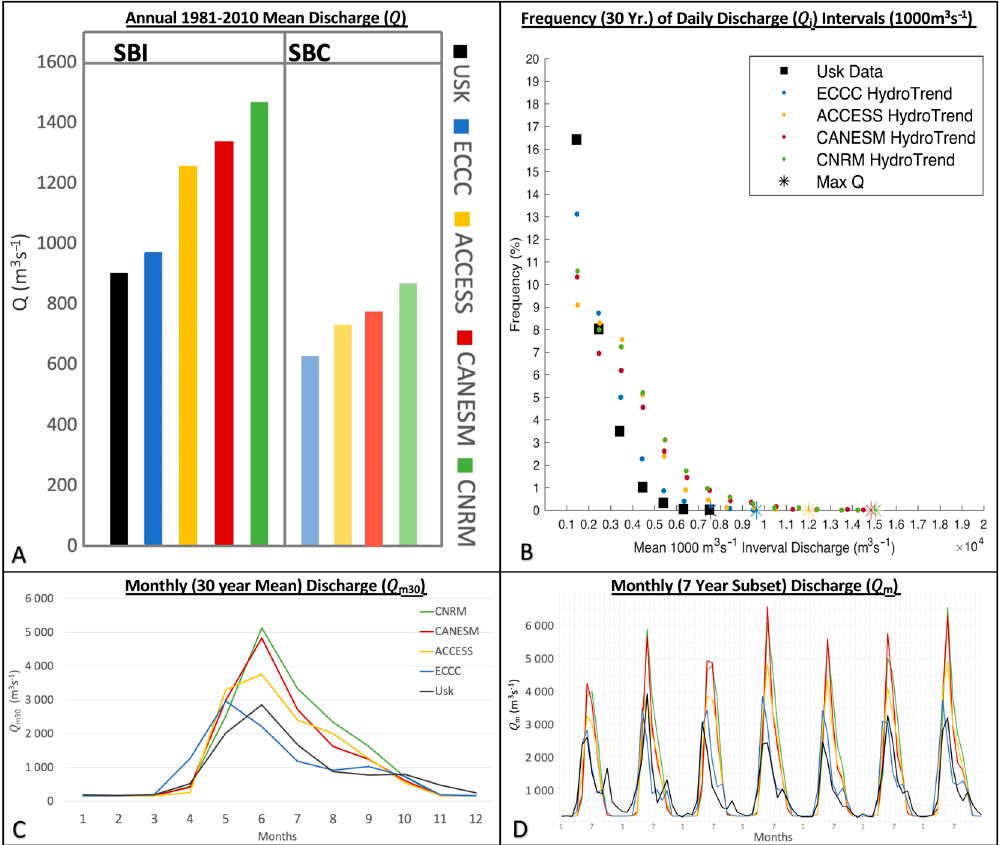
Figure 3. Validation of modelled discharge using HydroTrend model runs with varying climate input data. ( A ) 30-year mean annual discharge (Q a ) of SBI (modelled and measured) and SBC (modelled, only), ( B ) frequency of daily discharge (Q d ) for SBI, ( C ) 30-year mean monthly discharge (Q m ) for SBI and ( D ) monthly mean discharge (Q m ) for SBI (subset of 7 years). A two-tailed t-test comparing measured and modelled 𝑄 (cid:3040) (cid:3364)(cid:3364)(cid:3364)(cid:3364) showed that p -values were 0.57, 0.5, and 0.38 for ACCESS, CANESM and CNRM, respectively. Out of the model runs, ECCC is closest to the measurements, with a p -value of 0.98 (Figure 4A). ECCC over- estimated 𝑄 (cid:3028) (cid:3364)(cid:3364)(cid:3364)(cid:3364) by only 1%. GCMs overpredicted the Usk discharge by 29% (260 m 3 s − 1 ), 37% (330 m 3 s − 1 ), 51% (460 m 3 s − 1 ) for ACCESS, CANESM, and CNRM respectively (see